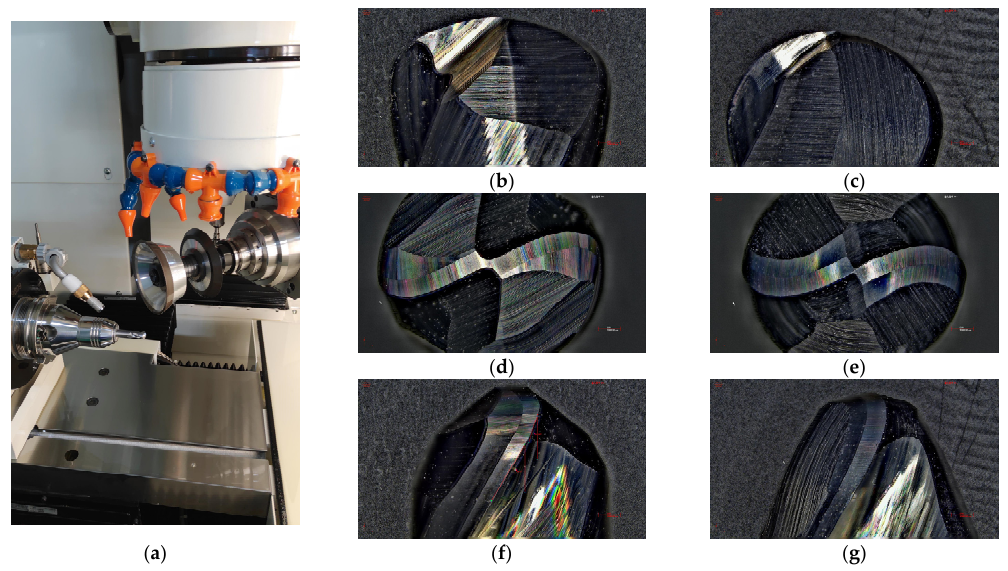
Figure 12. Grinding site and cutting tools: ( a ) grinding site of DACT and BEM; ( b ) front view of DACT; ( c ) front view of BEM; ( d ) top view of DACT; ( e ) top view of BEM; ( f ) side view of DACT; ( g ) side view of BEM.